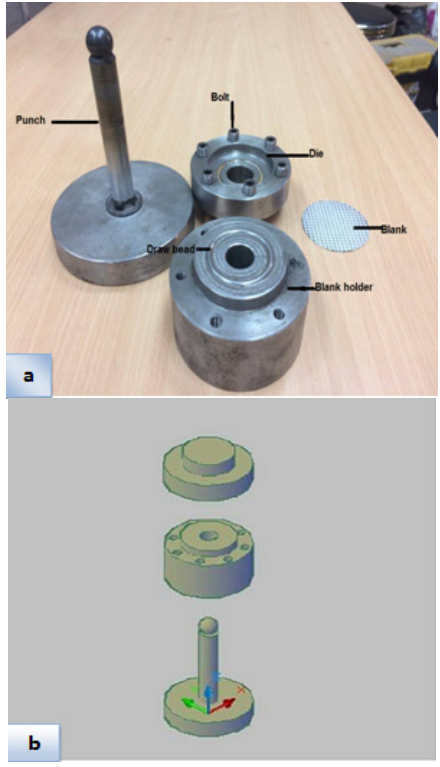
Fig. 5. Specimen with grid, A. before bulge test, B. after bulge